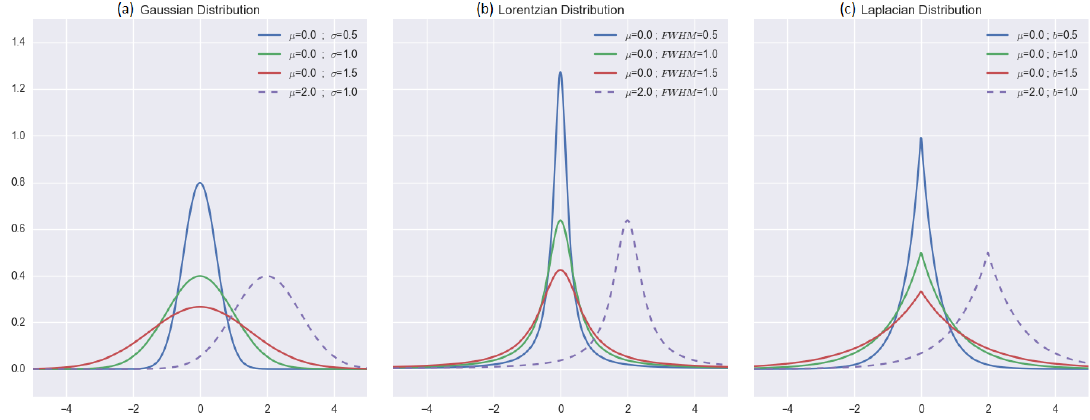
Figure 4. Distribution methods that are proposed in this work for comparisons: ( a ) Gaussian; ( b ) Lorentzian and ( c ) Laplacian distributions. Within the proposed DDW, the horizontal axis represents the distance, and the vertical axis is the weight